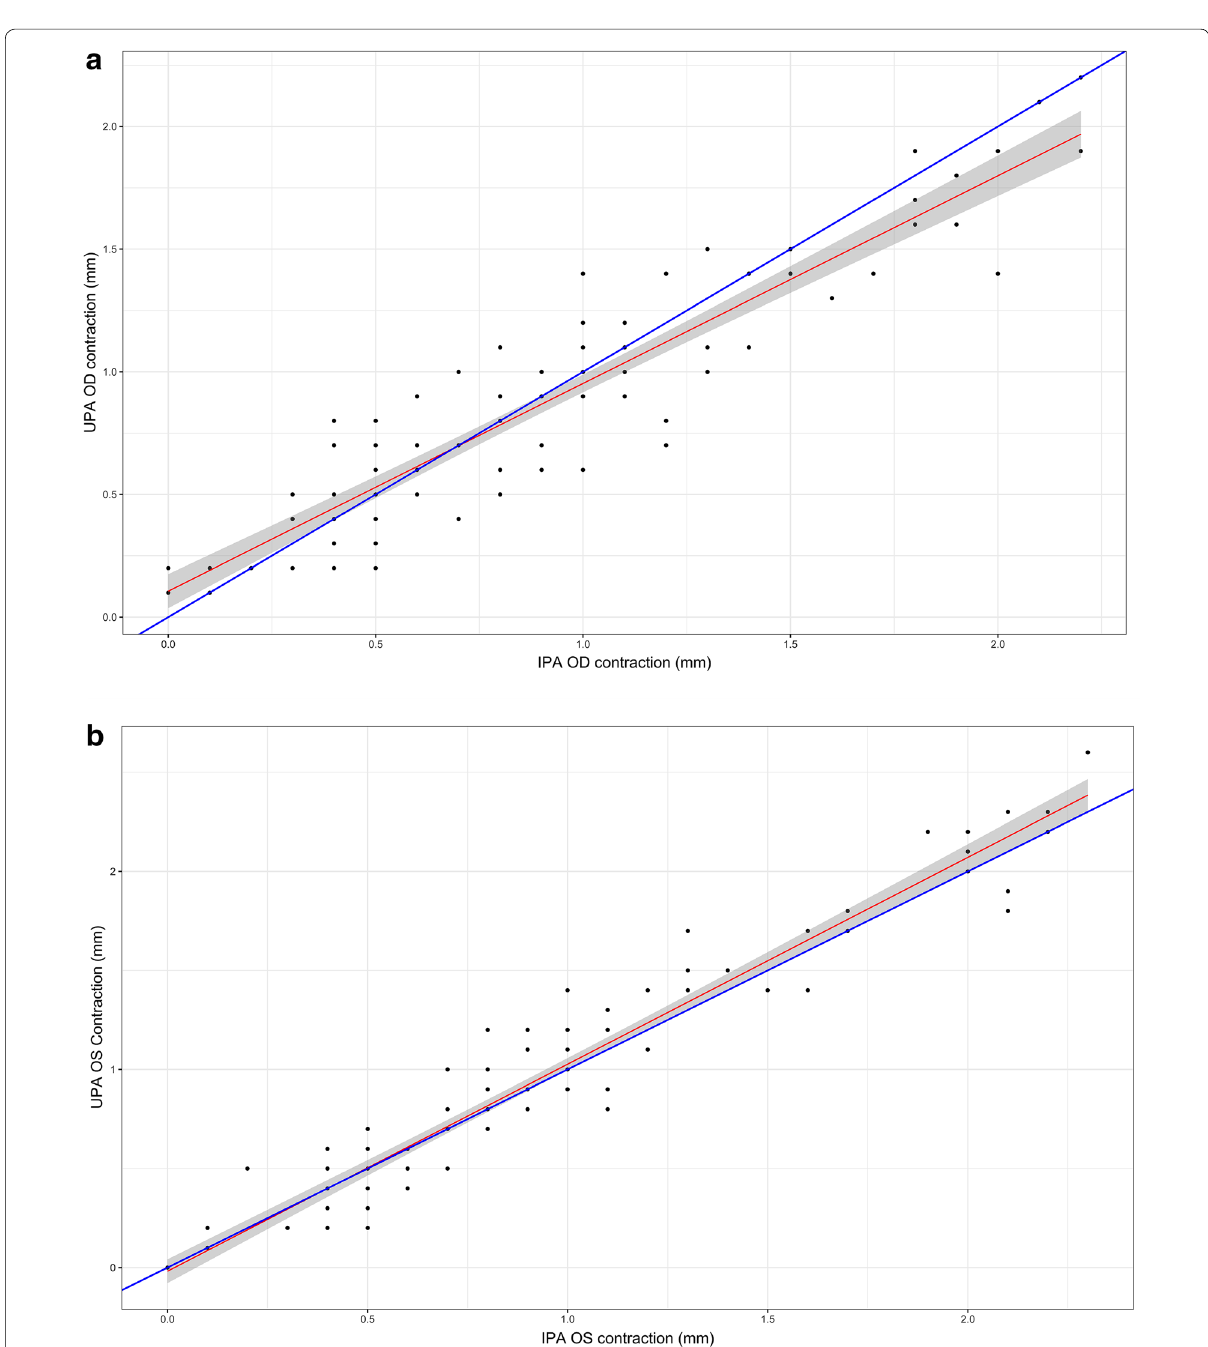
Fig. 4 Scatterplot. Panels a and b demonstrate correlation between UPA and IPA for OD and OS, respectively. Panels c and d demonstrate correlation between UPA and IPA for OD and OS, respectively, in neurocritically ill patients. The blue line would be the perfect match between both techniques. The red line is the fit of a regression on the set of